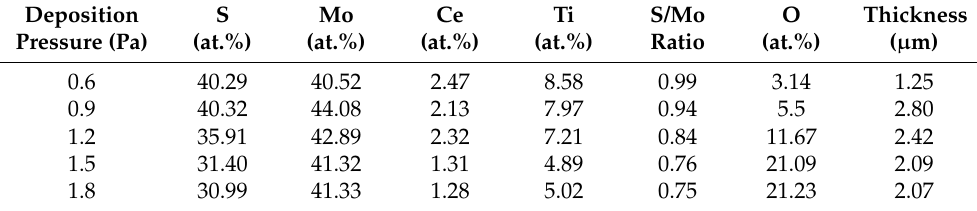
Table 3. Chemical composition and thickness of Ce-Ti/MoS 2 coatings.